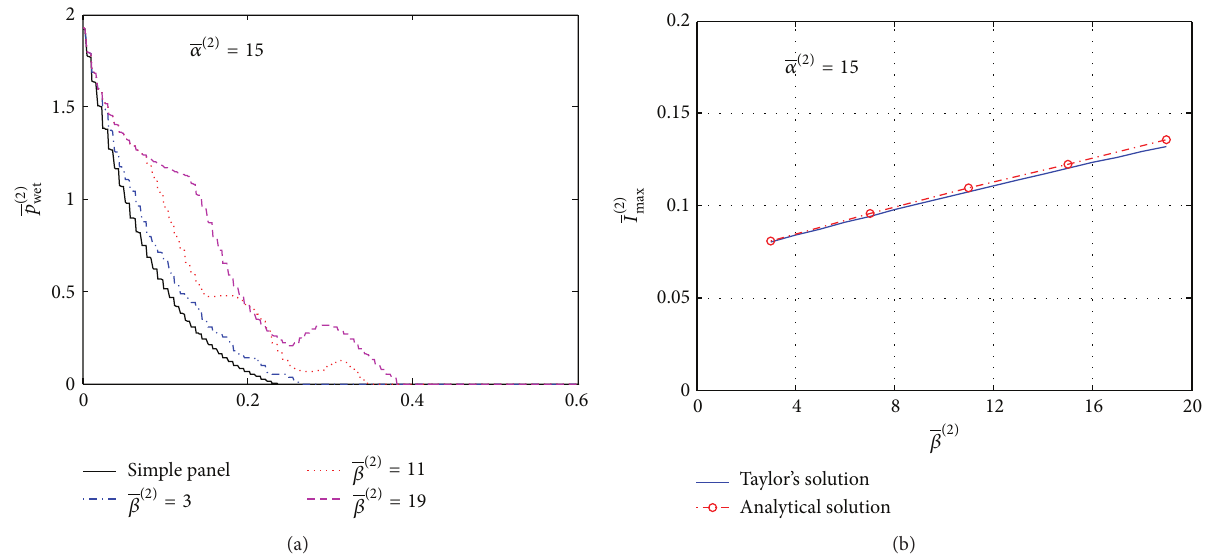
(2) wet for the panel with stiffener (T-shaped) with the parameters 𝛽 (2) for the panel with stiffener (T-shaped), max to the normalized parameter